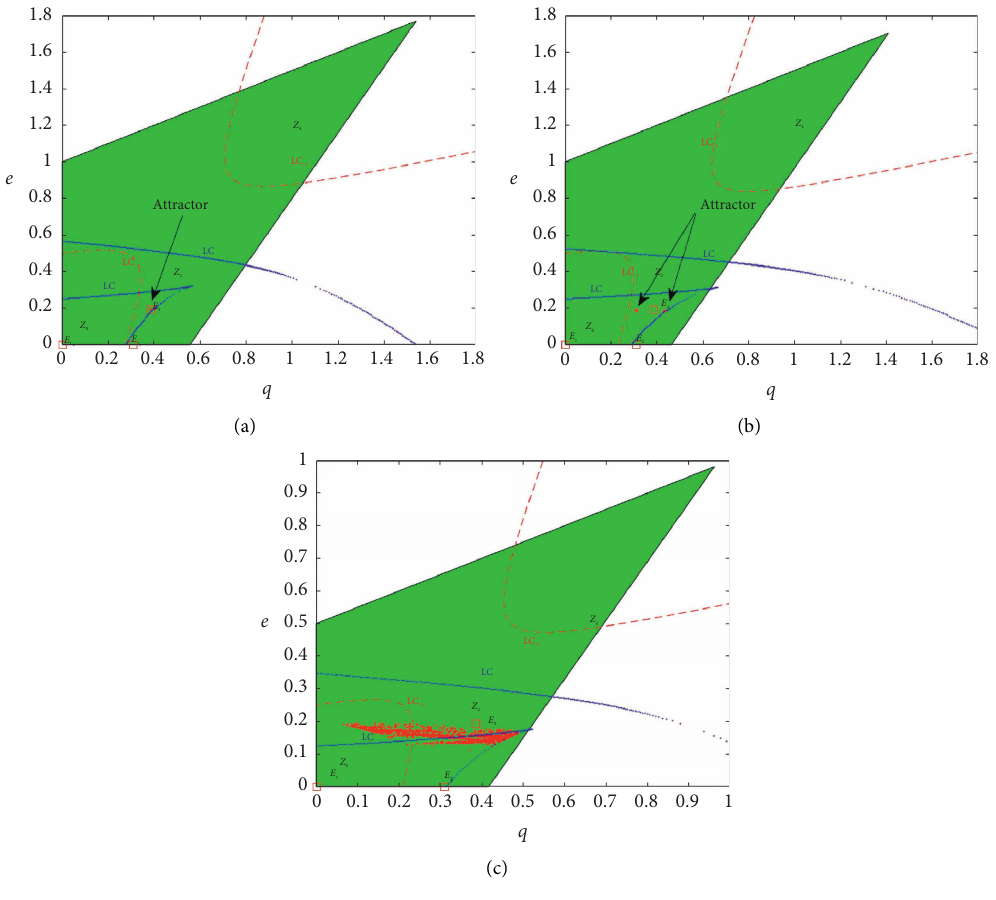
Figure 10: The basin of attraction and attractors. (a) α